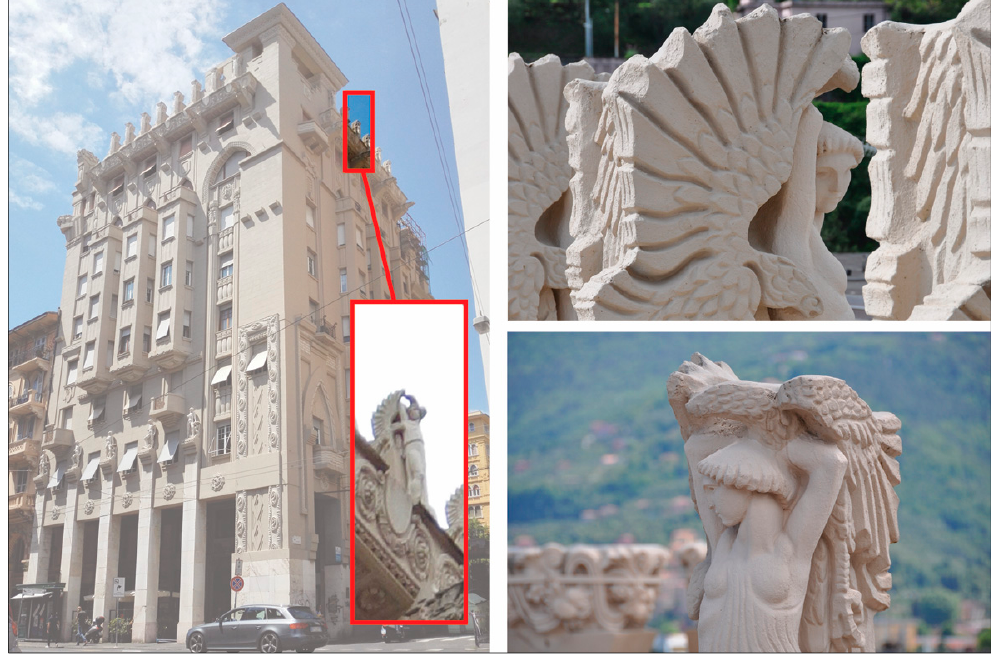
Figure 3. The statue of the building crowning, object of experimentation. Left: in evidence the position in the building. Right: details. (Bottom right photo by